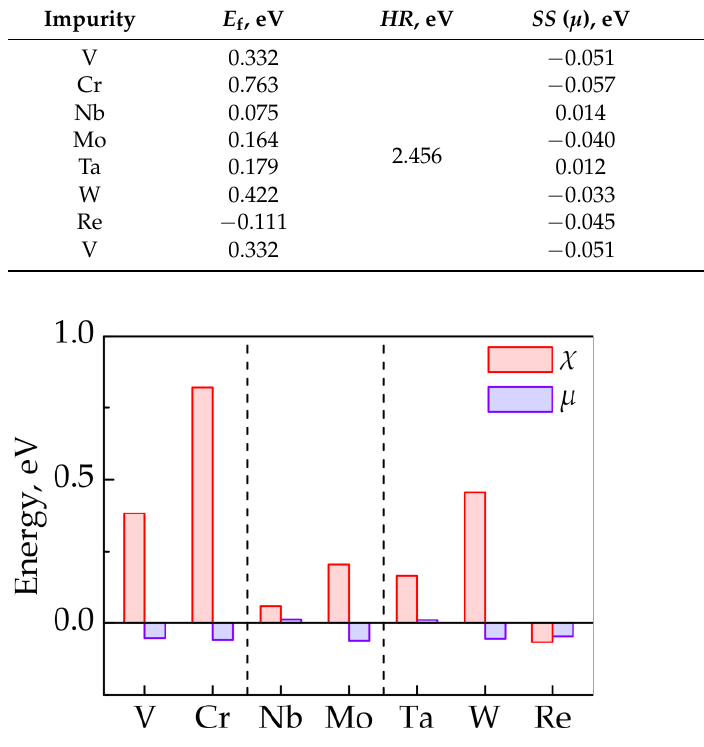
Figure 3. Both chemical ( χ ) and mechanical ( μ ) contributions to the defect formation energy. Figure 4 shows the values of the contribution µ versus the difference ( ∆ R cov ) in covalent radii of impurity and titanium atoms [46]. It can be seen that µ is in good agreement with ∆ R cov , the correlation coefficient R is 0.88, and the standard deviation σ is 0.013 eV. At the same time, the chemical contribution is not only determined by the hybridization contribution, which can be estimated by calculating the Crystal Orbital Hamilton Populations (COHP) [47,48]. Note that the COHP curve integrated up to the Fermi level and, taken with the opposite sign ( − ICOHP), can be considered as a measure of the hybridization contribution. Thus, as seen from Figure 5, the correlation between χ and the values of − ICOHP is weak enough: R equals − 0.61 and σ = 0.216 eV. Unfortunately, it is quite difficult to estimate the metallic contribution to the chemical bonding, while